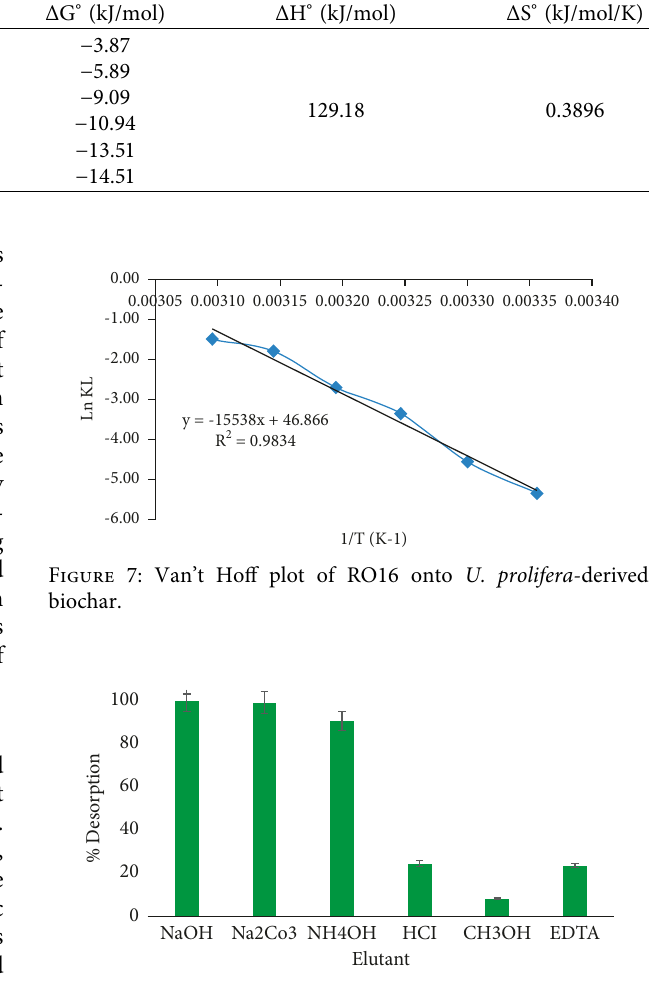
Figure 8: Desorption efficiency of RO16 from biochar for different